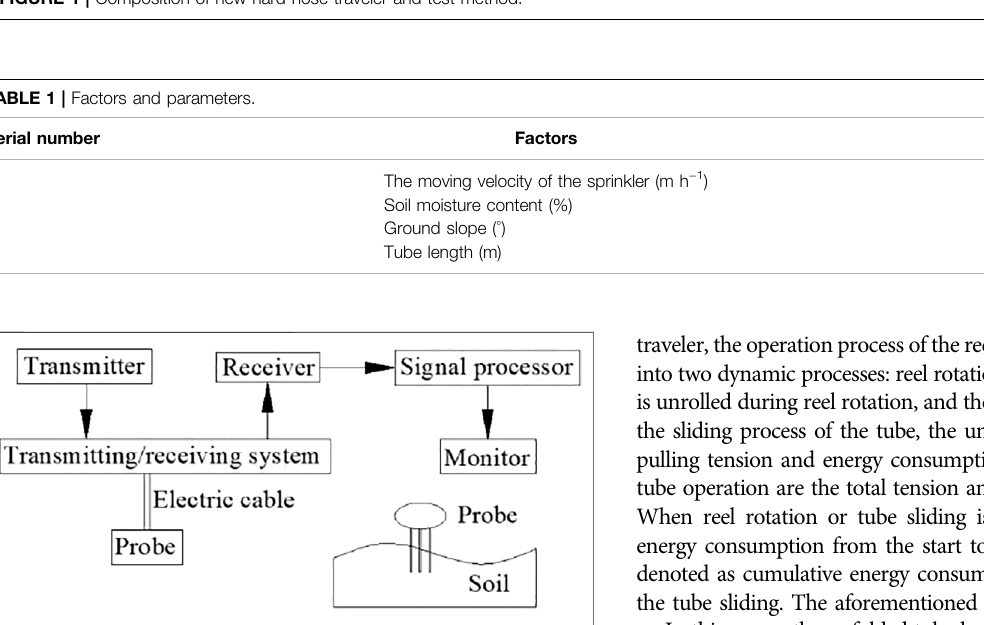
FIGURE 1 | Composition of new hard hose traveler and test method.